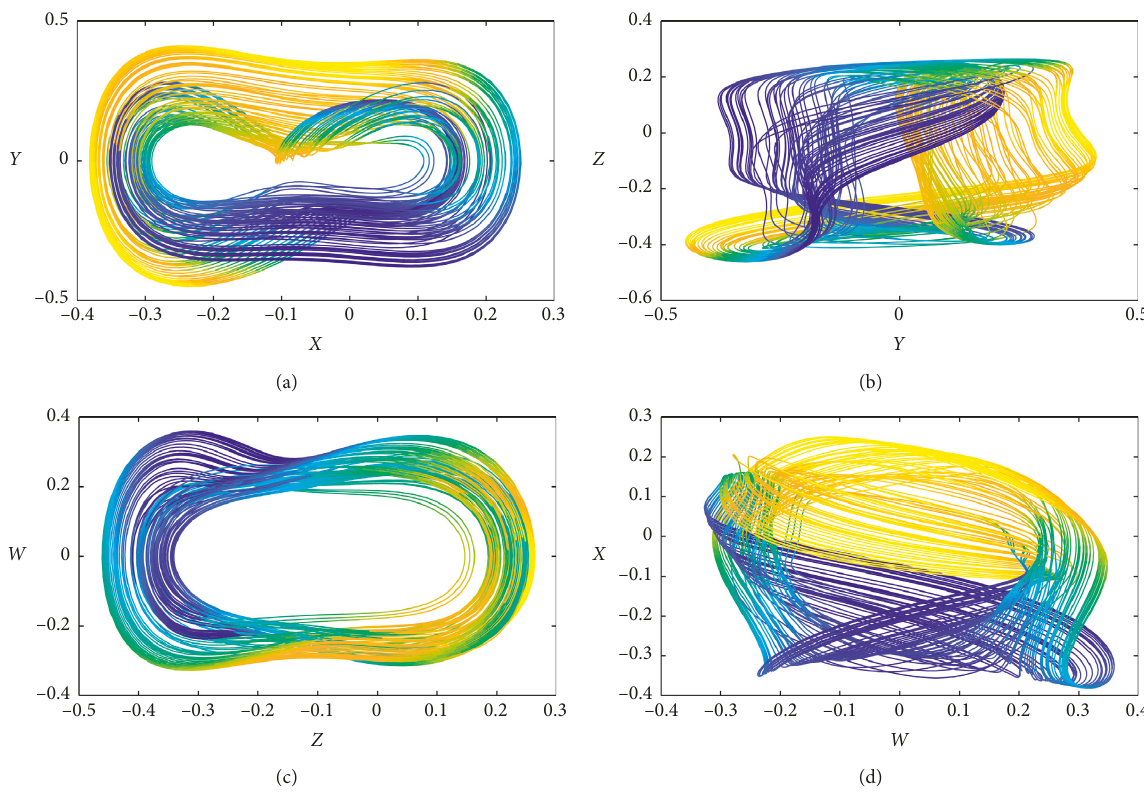
Figure 2: 2D phase portraits of the ASHS.